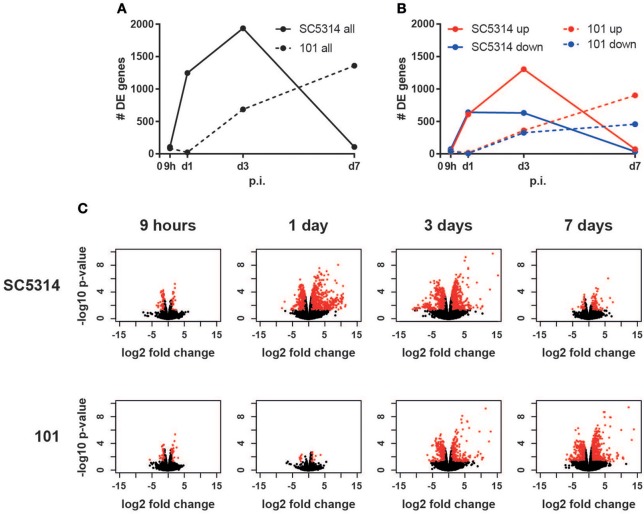
The host response to C. albicans strain 101 is delayed compared to strain SC5314. Epithelial sheet from C. albicans strain SC5314- and strain 101-infected WT mice were subjected to RNA-seq analysis. (A) Graph showing the total number of differentially expressed (DE) genes at the indicated time points compared to naïve controls. (B) Separate display of the up- and down-regulated genes at the indicated time points. (C) Volcano plots displaying the fold changes and the FDR of all genes detected in each condition separately. Genes with FDR < 0.05 and fold change < −2 or > 2 are marked in red.